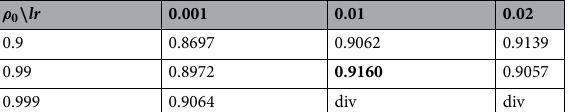
Table 2. Test accuracy of Resnet-20, trained on Cifar-10 for 200 epochs versus Coolmomentum hyperparameters lr and ρ 0 . “div” means “divergent”. The best value is in